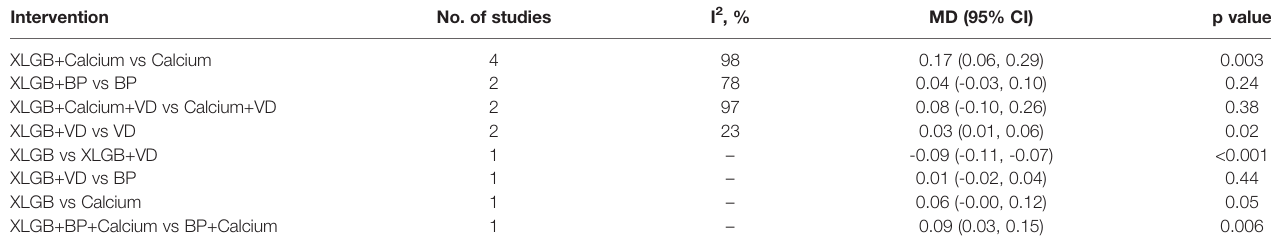
TABLE 3 | Traditional Meta-analysis of femoral neck